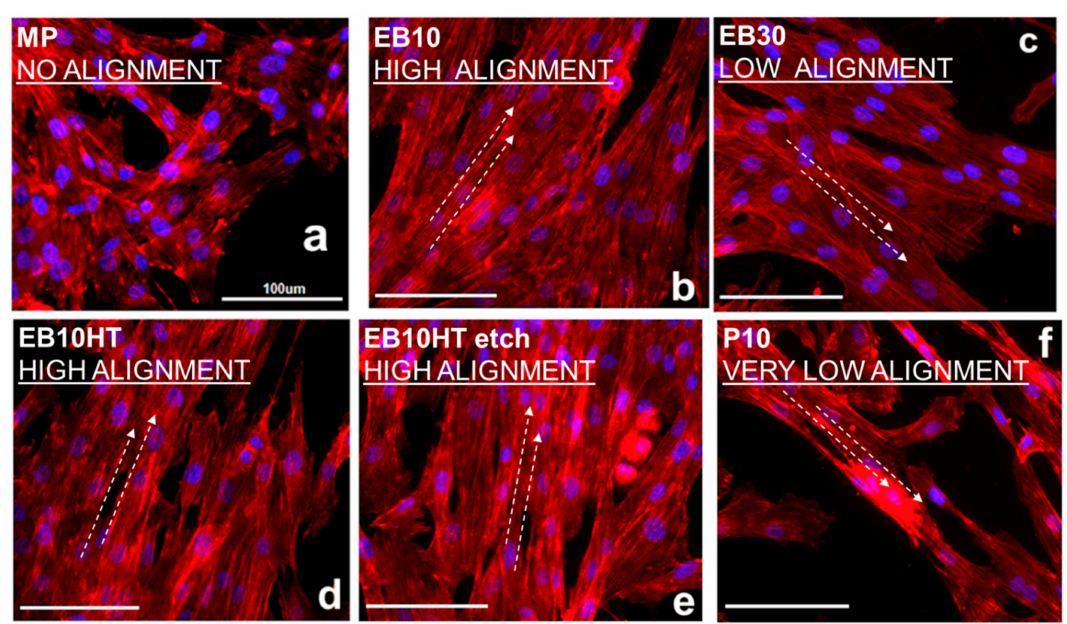
Figure 4. Fibroblast alignment on the di ff erent samples after 48 h culture: ( a ) MP sample; ( b ) EB10 sample; ( c ) EB30 sample; ( d ) EB10HT sample; ( e ) EB10HT etch sample; ( f ) P10 sample.